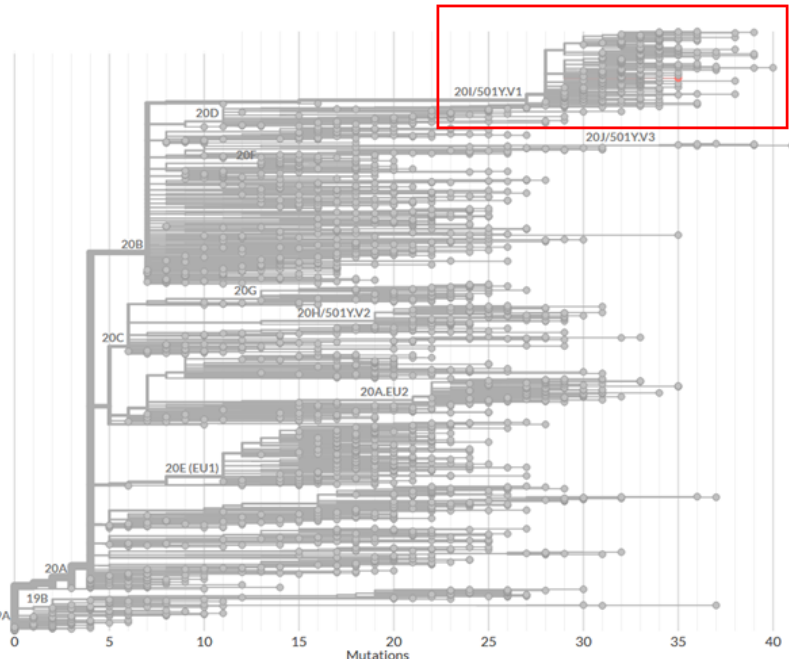
Figure 1. Phylogenetic tree analysis of the full-genome sequence of the strain detected in the deceased resident (analysis was performed using the online application Nextclade beta [24]).